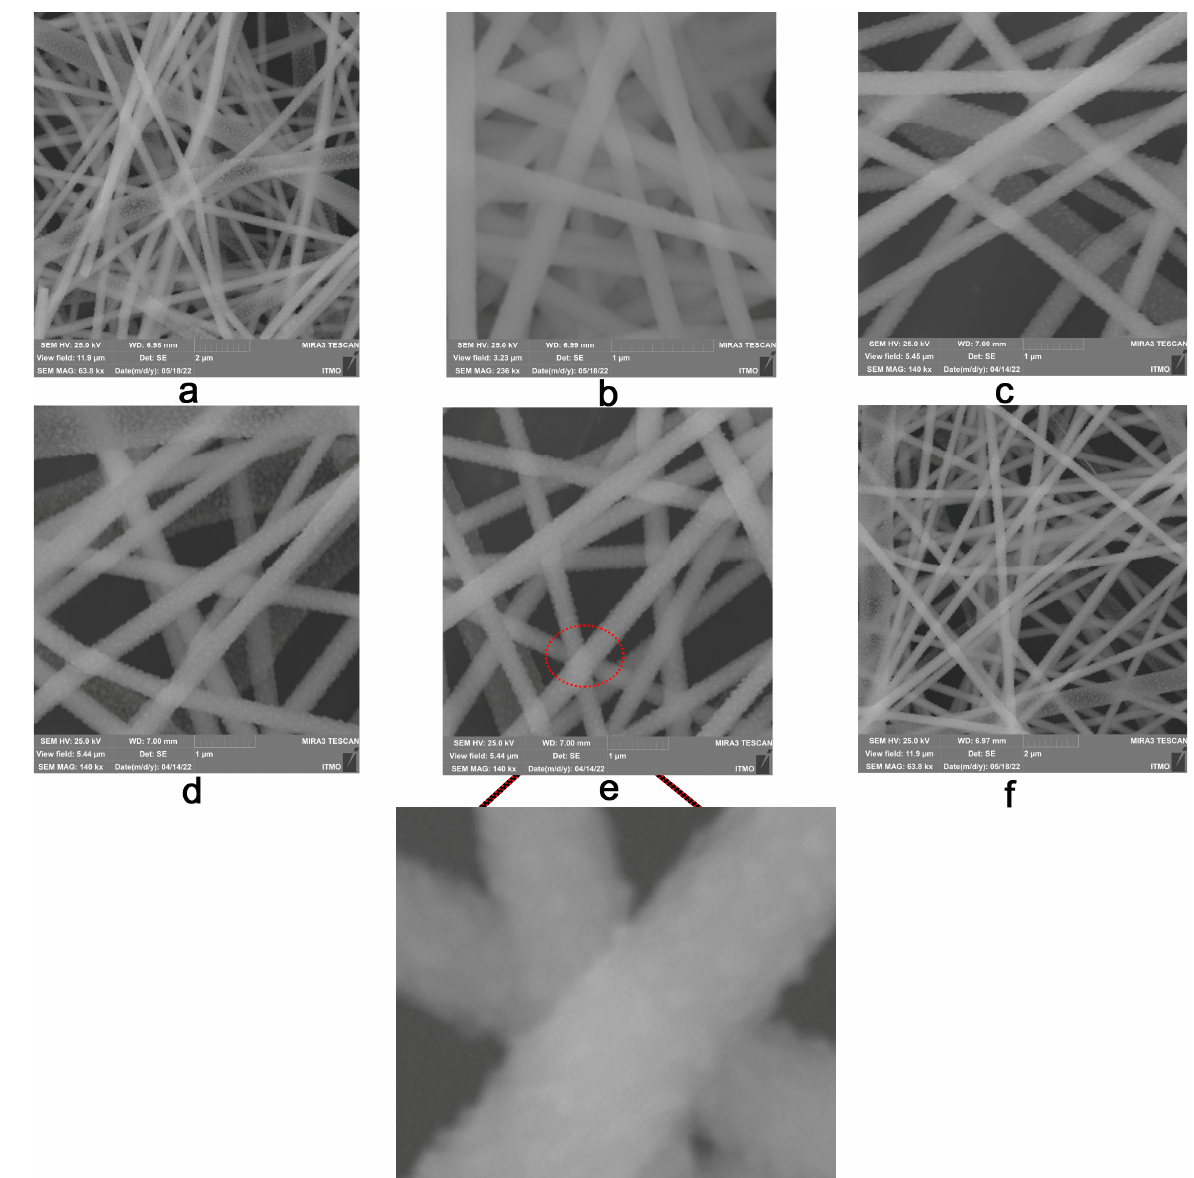
Figure 2. Structure of annealed nanofibers: ( a ) sample 1 and ( b ) sample 2, prepared at 20 kV and 23 kV, respectively; ( c ) sample 3 and ( d – f ) samples (4–6), collected using planar and rotary (250, 500, 750 rpm) collectors, respectively. Sample 1 (voltage: 20 kV, distance: 150 mm, needle diameter: 0.42 mm, feed rate: 0.1 mL/h, planar collector); Sample 2 (23 kV, 150 mm, 0.42 mm, 0.1 mL/h, planar collector); Sample 3 (20 kV, 150 mm, 0.72 mm, 0.3 mL/h, planar collector); Sample 4 (20 kV, 150 mm, 0.72 mm, 0.3 mL/h, rotary collector (250 rpm)); Sample 5 (20 kV, 150 mm, 0.72 mm, 0.3 mL/h, rotary collector (500 rpm)); Sample 6 (20 kV, 150 mm, 0.72 mm, 0.3 mL/h, rotary collector (750 rpm)).